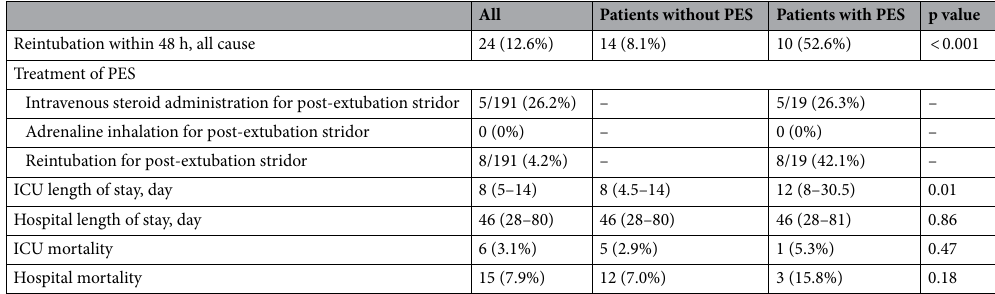
Reintubation within 48 h, all cause